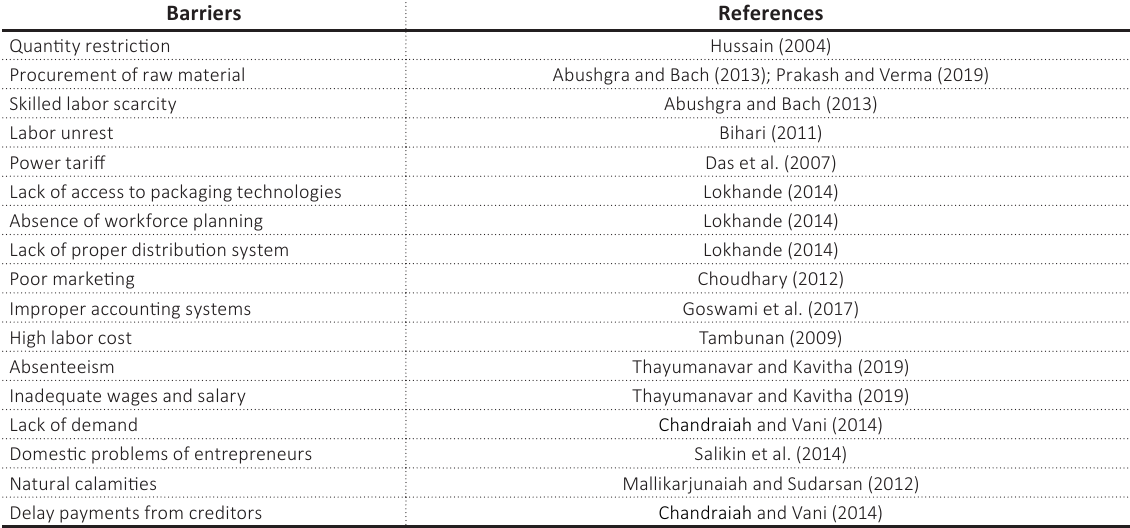
Table 1 (cont.). Conceptual literature